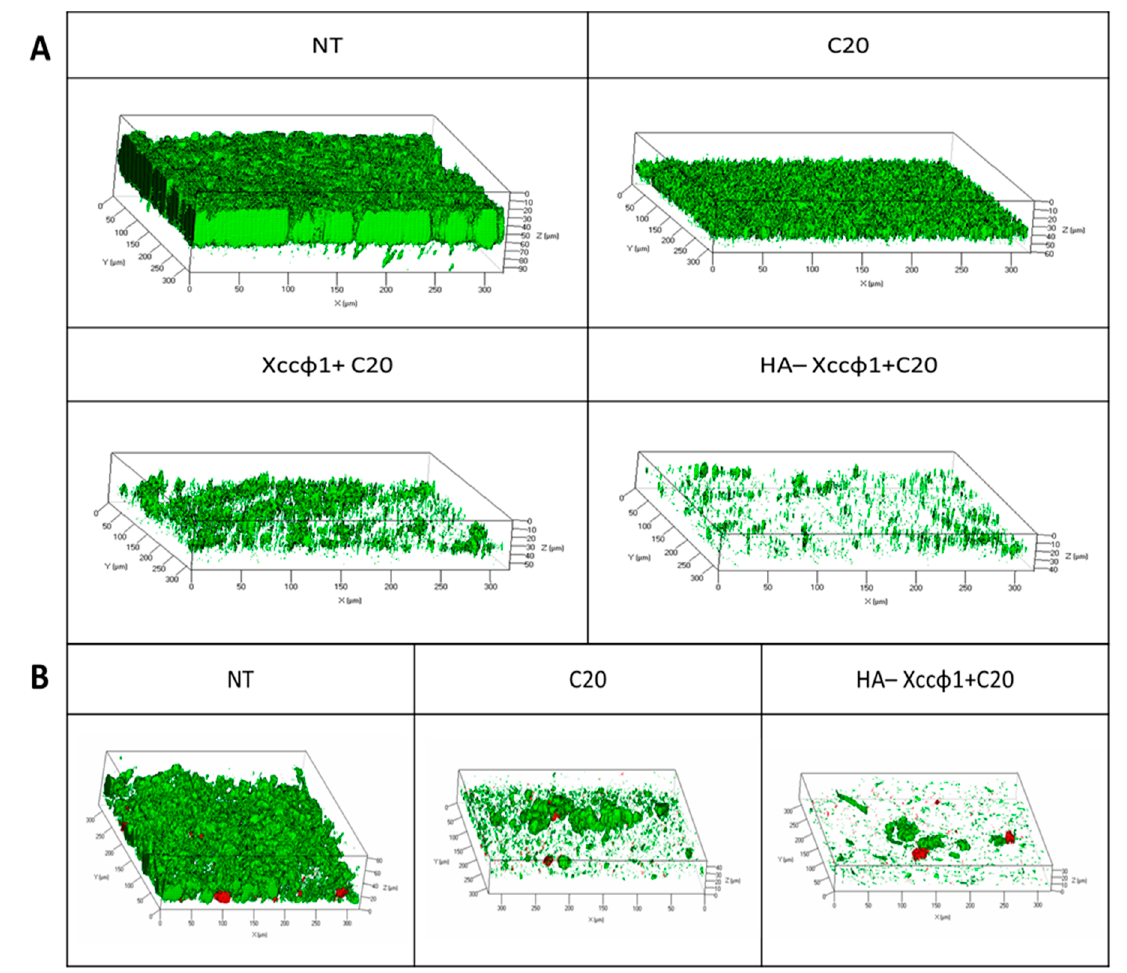
Figure 3. ( A ) Analysis of the anti-biofilm effect of eicosanoic acid (C20:0) alone, with Xcc φ 1, and in combination with Xcc φ 1 and HA on Xcc mature biofilm. CLSM analysis was performed on 72 h mature Xcc biofilms after 3 h of treatment at Room Temperature. The biofilm structures were stained using the LIVE/DEAD ® Biofilm Viability Kit. ( B ) Evaluation of biofilm formation of Xcc in dynamic conditions in the presence and absence of C20:0 and the complex of HA-Xcc φ 1+C20:0. Biofilm formation was performed in a three-channel flow cell for 48 h. CLSM analysis was performed after 3 h incubation at RT in the presence and the absence of the anti-biofilm samples.